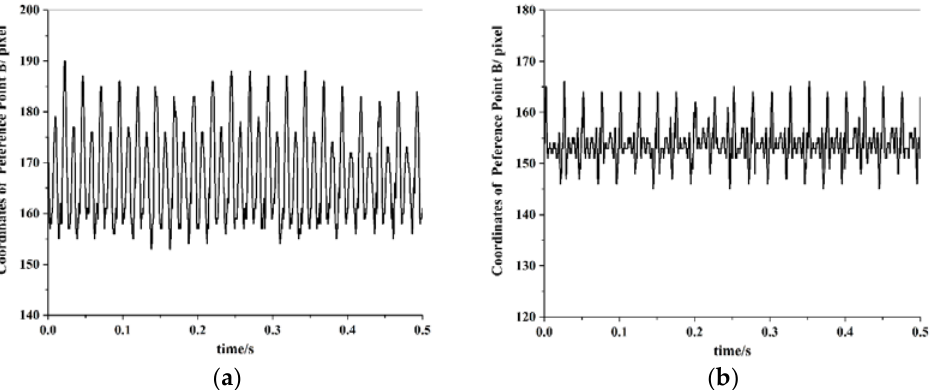
Figure 10. Height of reference point B on the pool surface as a function of time: ( a ) full penetration; ( b ) partial penetration.